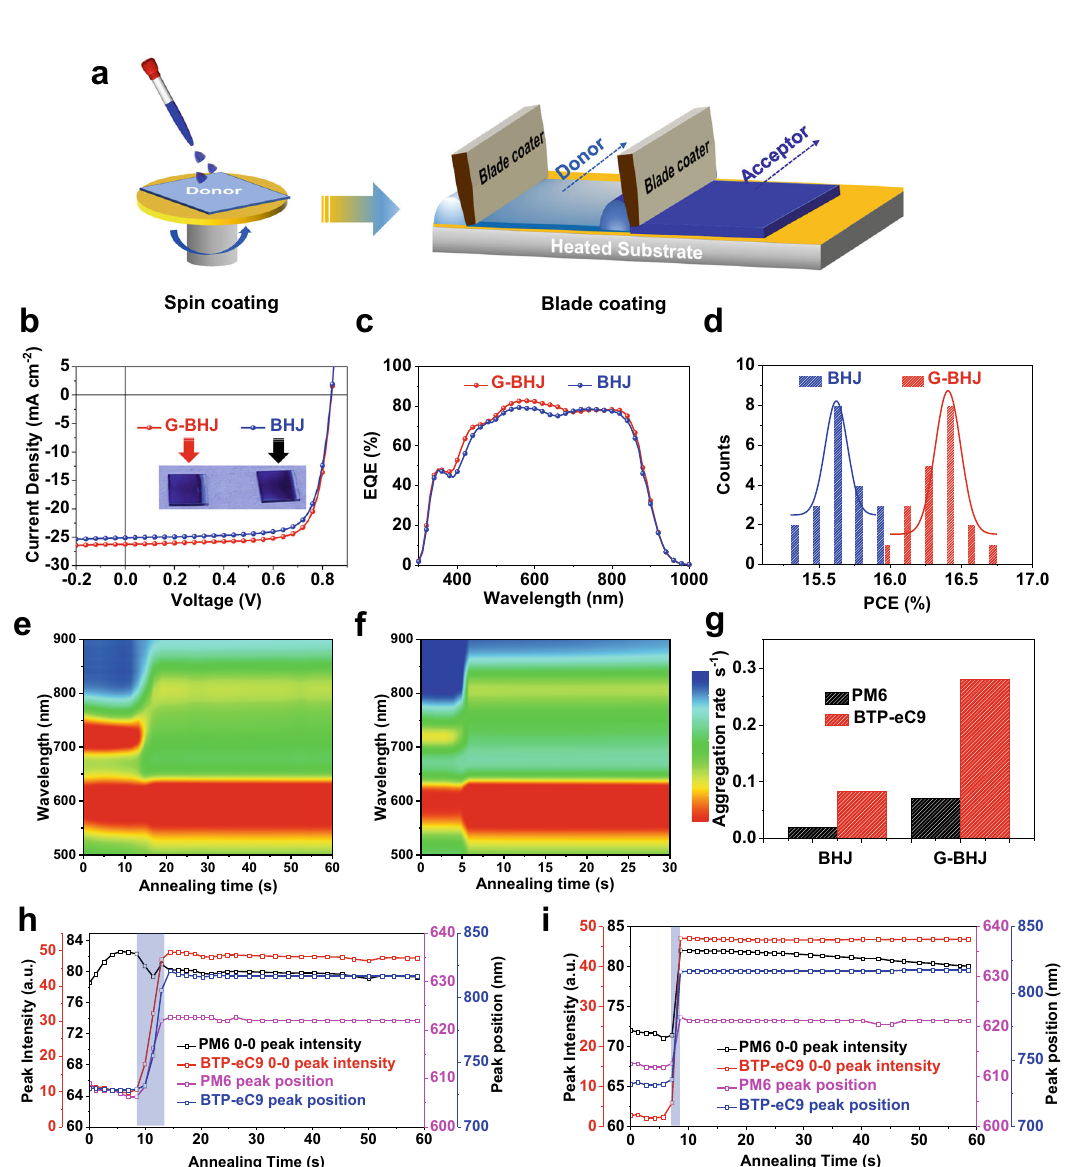
Fig. 6 The open-air blade coating device performances and in situ absorption characteristics for both BHJ and G-BHJ OSCs. a Schematic illustration of spin coating and blade coating for G-BHJ fabrication procedure. b J – V curves of the BHJ OSCs and G-BHJ OSCs. c EQE curves of the optimized BHJ OSCs and G-BHJ OSCs. d Histograms of the BHJ OSCs and G-BHJ OSCs based on 20 independent cells. Time-resolved UV-vis absorption spectra of e optimized BHJ and f G-BHJ OSCs fi lms. g Aggregation rate of PM6 and BTP-eC9 in optimized BHJ and G-BHJ active layers. The peak position and peak intensity evolution as a function of annealing time of PM6 and BTP-eC9 in h optimized BHJ and i G-BHJ fi lms.